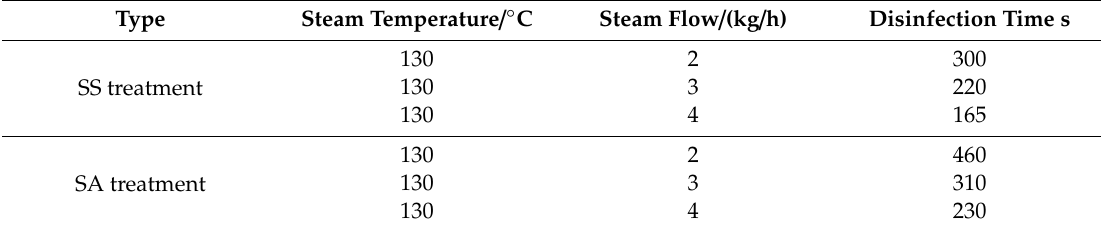
Table 4. Soil steam disinfection